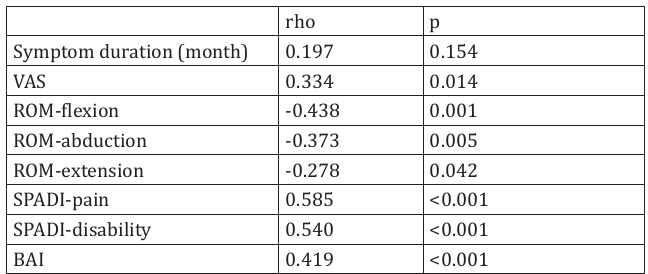
Correlations between Clinical Parameters and TSK